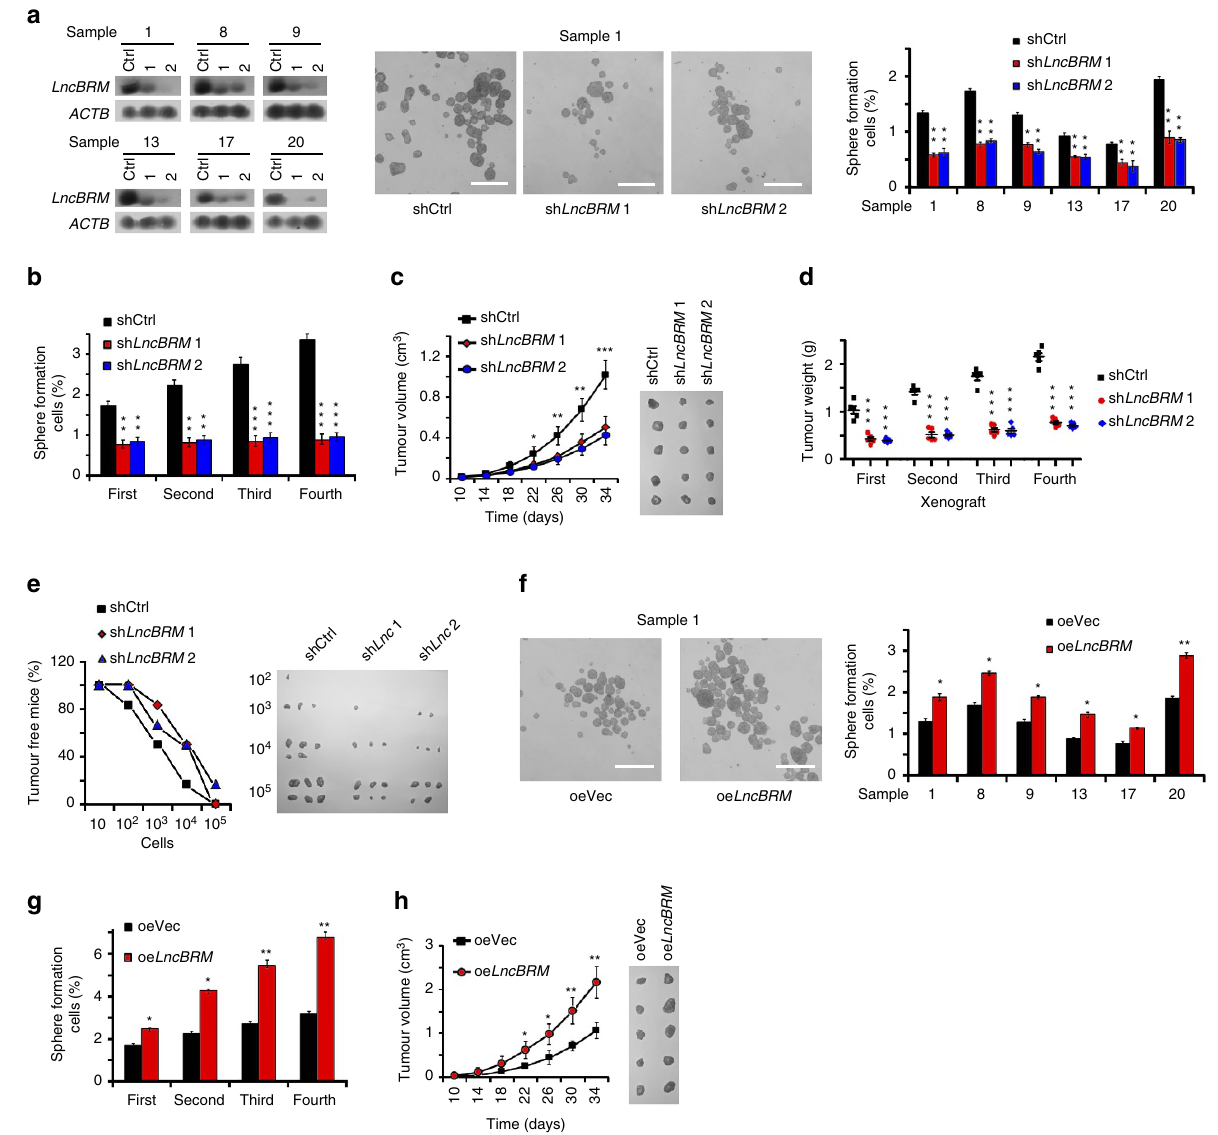
Figure 2 | LncBRM is required for the self-renewal maintenance of liver CSCs. ( a ) LncBRM -silenced cells from HCC samples were established and examined by northern blotting (left panel), followed by sphere formation assays. Representative sphere images were shown in the middle panel and statistic ratios were shown in the right panel. ( b ) Declined self-renewal capacities of lncBRM -depleted cells were detected by serial sphere formation assays. ( c ) LncBRM -depleted and control cells (1 (cid:3) 10 6 ) were injected into BALB/c nude mice, followed by measurement of tumour volumes. n ¼ 5 for each group. ( d ) LncBRM -silenced primary cells were established with pSiCoR lentivirus and used for subcutaneous injection. Xenograft tumours were used for serial tumour implantation. n ¼ 5 for each group. ( e ) LncBrm silenced and shCtrl cells (10, 10 2 , 10 3 , 10 4 and 10 5 ) were subcutaneously injected into BALB/c nude mice for observation of tumour growth. Tumour-free mice ratios and tumour sizes are shown. ( f ) LncBRM -overexpressing primary cells were established and used for sphere formation assays. ( g ) LncBRM -overexpressing cells were examined by serial sphere formation assays. ( h ) LncBRM -overexpressing cells were injected into BALB/c nude mice for observation of tumour growth and measurement of tumour volume every 4 days. n ¼ 5 for each group. Scale bars, 500 m m ( a , f ). Data are shown as means ± s.d. Two tailed Student’s t -test was used for statistical analysis; * P o 0.05, ** P o 0.01 and *** P o 0.001. Data are representative of four independent